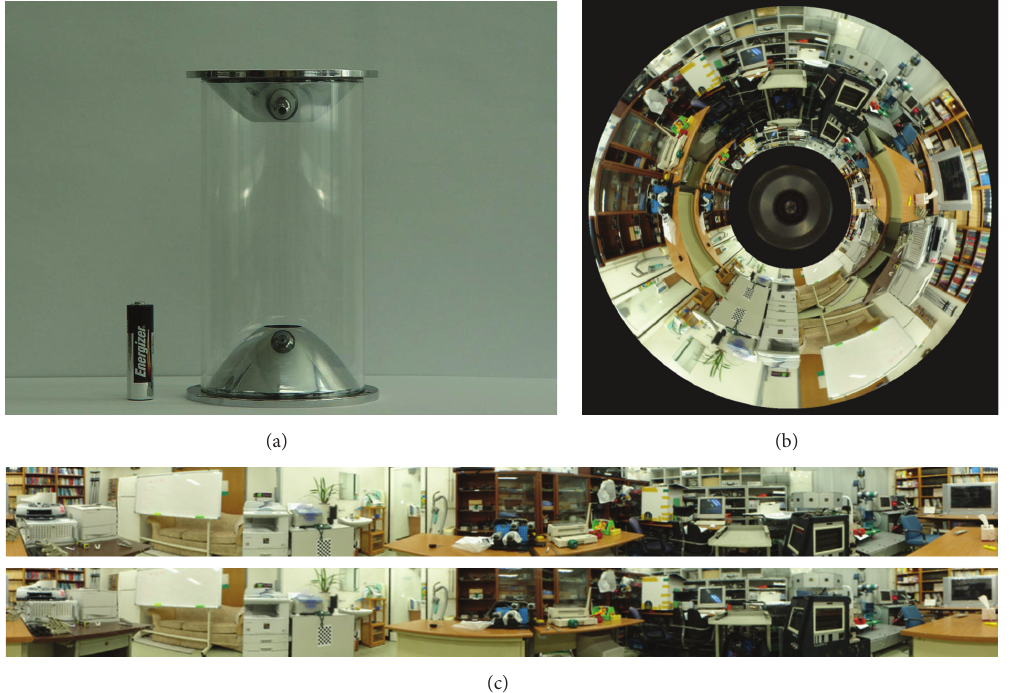
Figure 4: Omnidirectional stereo camera system: (a) parabola mirrors, (b) captured image, and (c) rectified images.